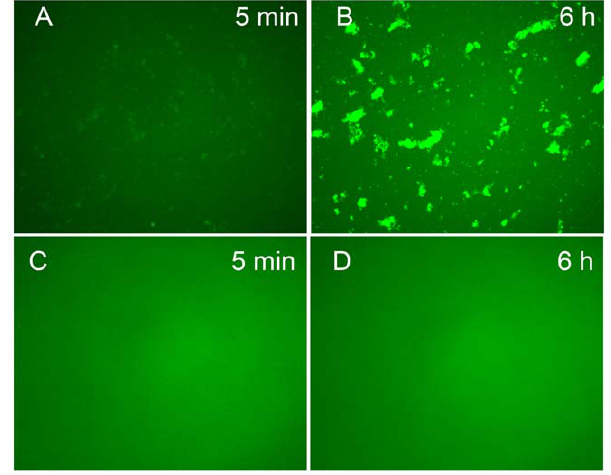
Figure 4. a A-(66-80) Peptide–induced HMW aggregate forma- tion. Aggregates formed after incubation mixtures of 25 m g a A-(66-80) peptide with 200 m g a -crystallin, as described under methods, were re- suspended with Alexa-488 labelled a B-crystallin ( a BT162C-488) in 50 mM phosphate buffer, pH 7.2, and the mixture was incubated at 37 u C. The protein sample was removed after 5 min and 6 hrs and placed on a pre-cleaned glass slide and observed under the Leica fluorescence microscope using blue filter. The image was captured at 20 6 magnification. (A) Sample after 5 min; (B) sample after 6 h. As a control, a mixture of a A-(66-80-Pro) peptide–treated a -crystallin was incubated overnight and an aliquot was mixed with a BT162C-488 and observed under fluorescence microscope at 5 min (C) and 6 h D). The results show that a -crystallin aggregates formed after incubation with a A-(66-80) peptide bind a B-crystallin. The findings suggest that peptide- a -crystallin acts as a nucleus for binding of a B-crystallin.